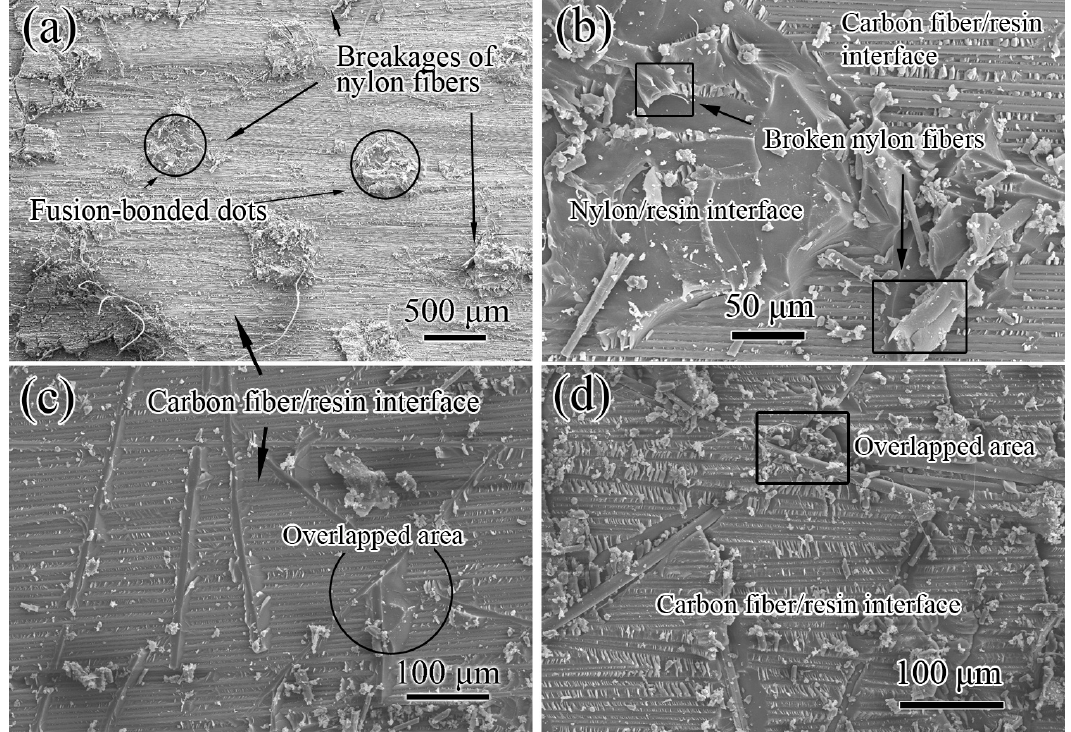
Figure 7. SEM images of the Mode II fracture surfaces of interleaved composites. ( a ) and ( b ) are NVIC, and ( c ) and ( d ) are